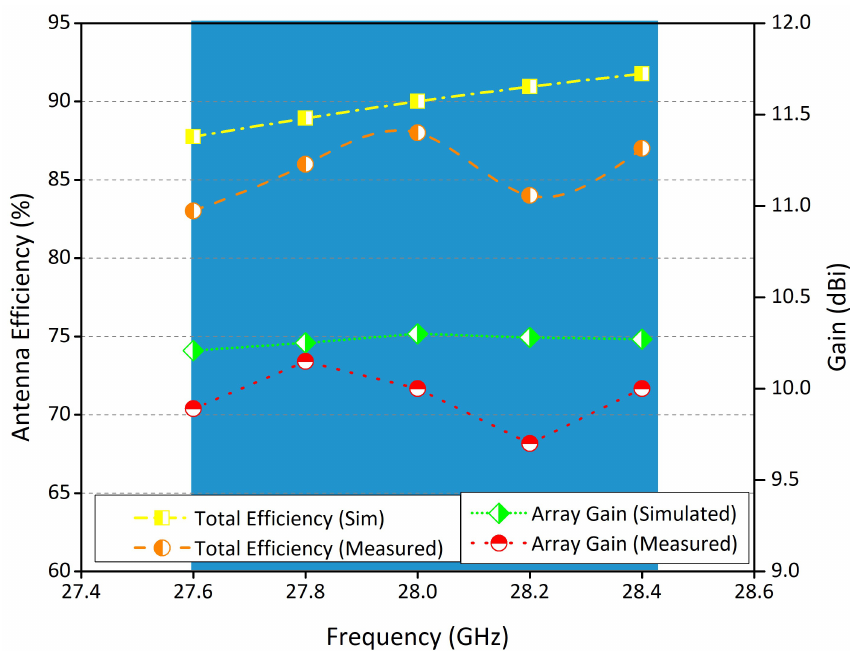
Figure 8. Gain and efficiency plots of the antenna array.